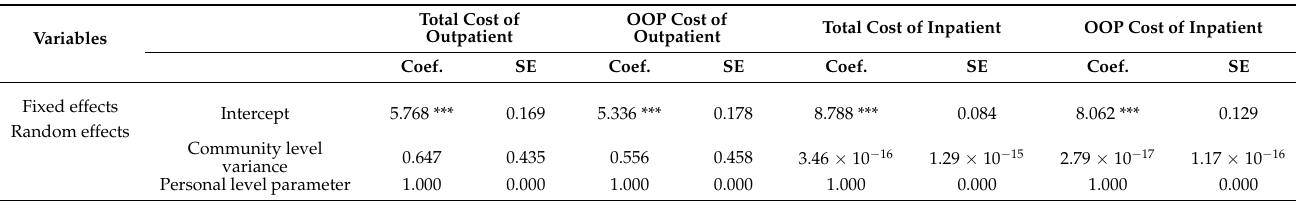
Table 3. Two empty models of influencing factors of health service utilization.